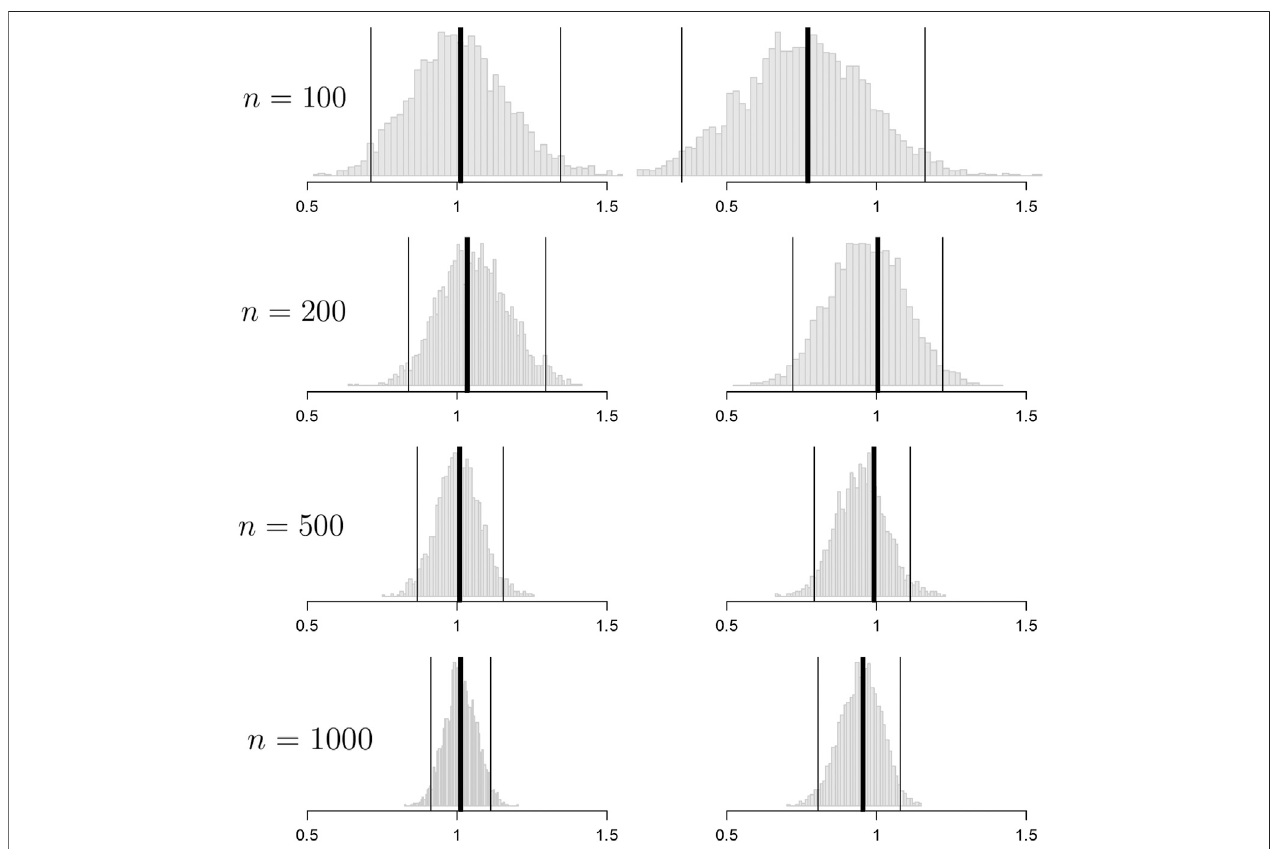
FIGURE 2 | Histograms of the bootstrap samples of the out-of-sample improvement measures for d 0 random (left column) and d 0 best (right column) for the response model of Eq. 11 for different values of n . (cid:12) I 0 is illustrated with a thick black line. The CI μ